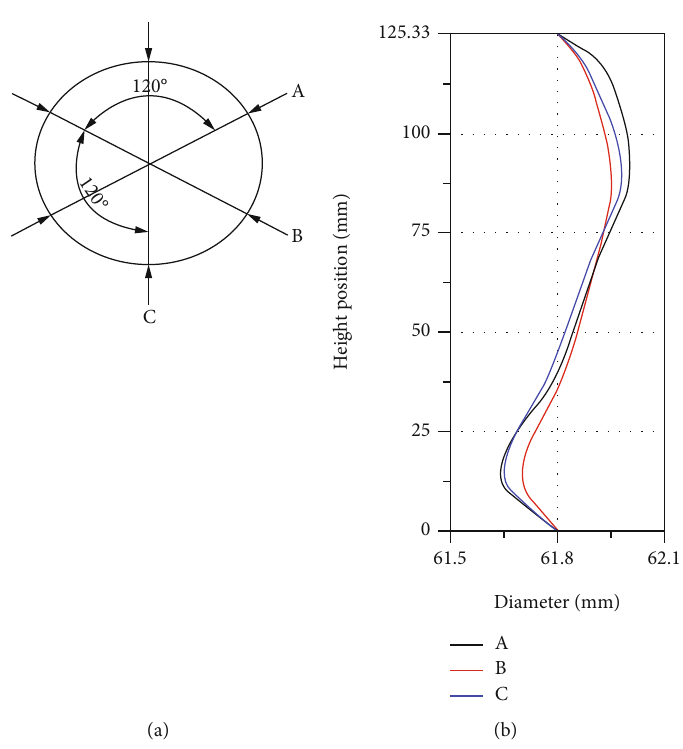
Figure 14: Ice sample diameter: (a) measurement intervals and (b) measurement